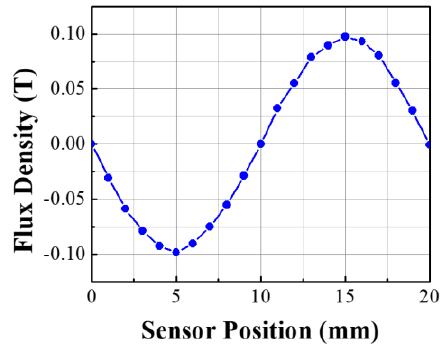
Figure 4. Distribution of the flux density at the center of g module over the stator tooth-slot.